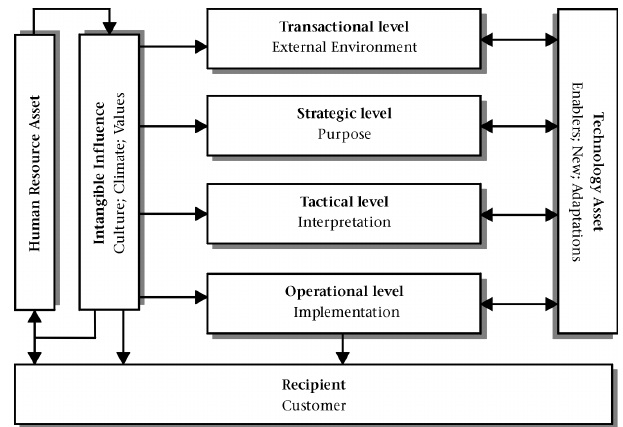
Figure 6: Proposed diffusion framework of innovative practices within the